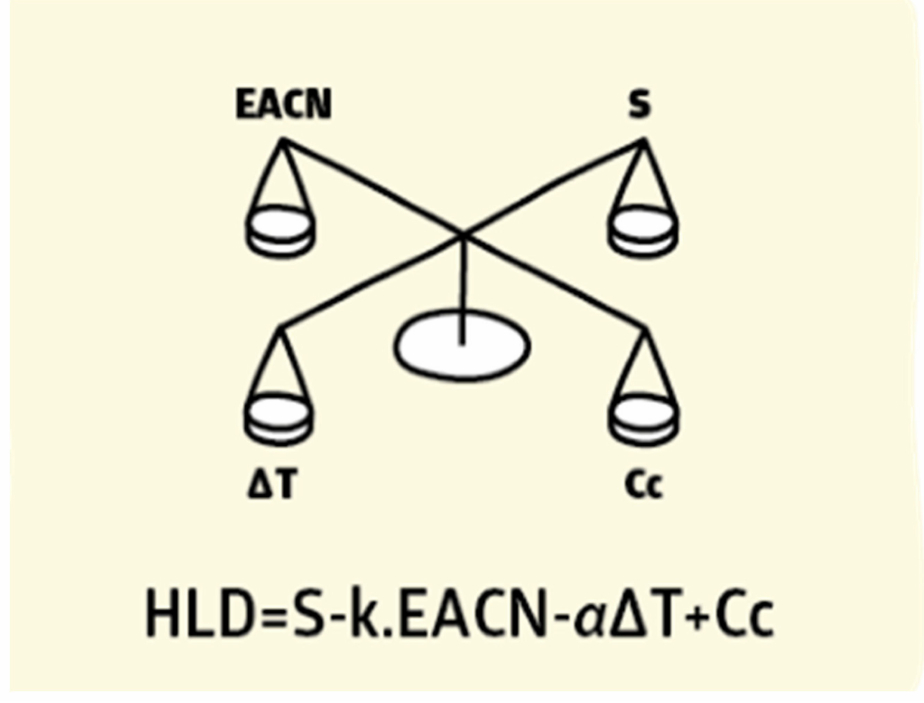
Figure 14. HLD as a balancing of system conditions